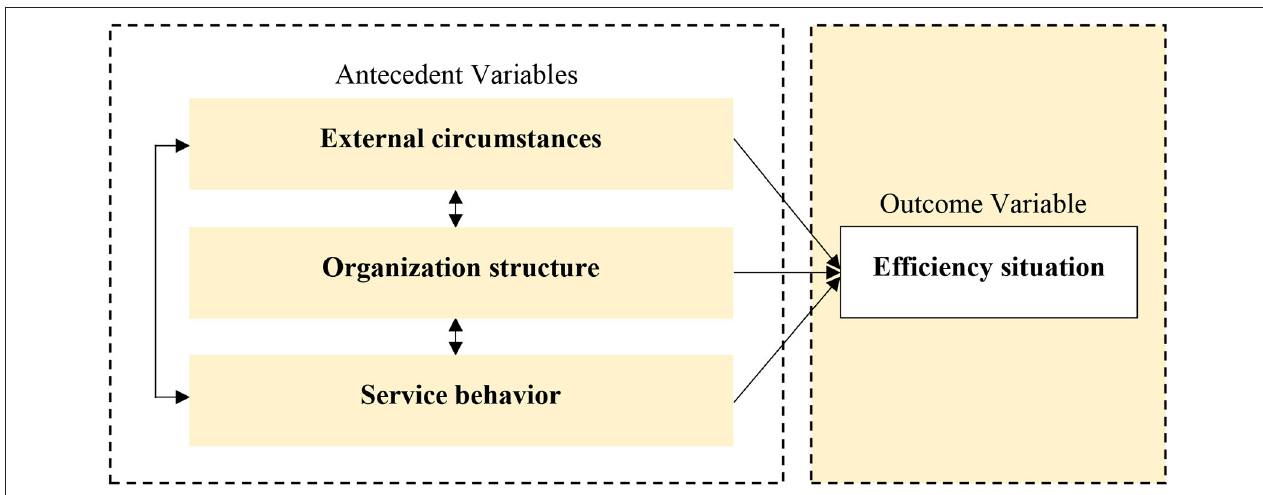
FIGURE 1 | Environment-structure-behavior analytical